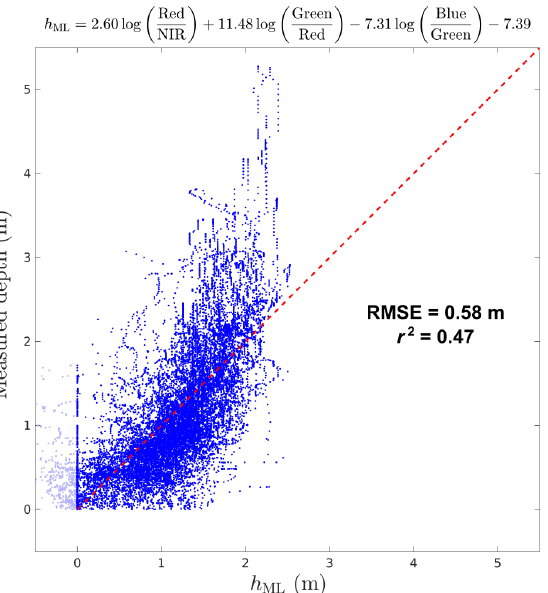
Figure 15. Result of a Multiple Linear (ML) regression against all three independent log-ratios. Negative predicted values have been set to zero before the computation of RMSE and r 2